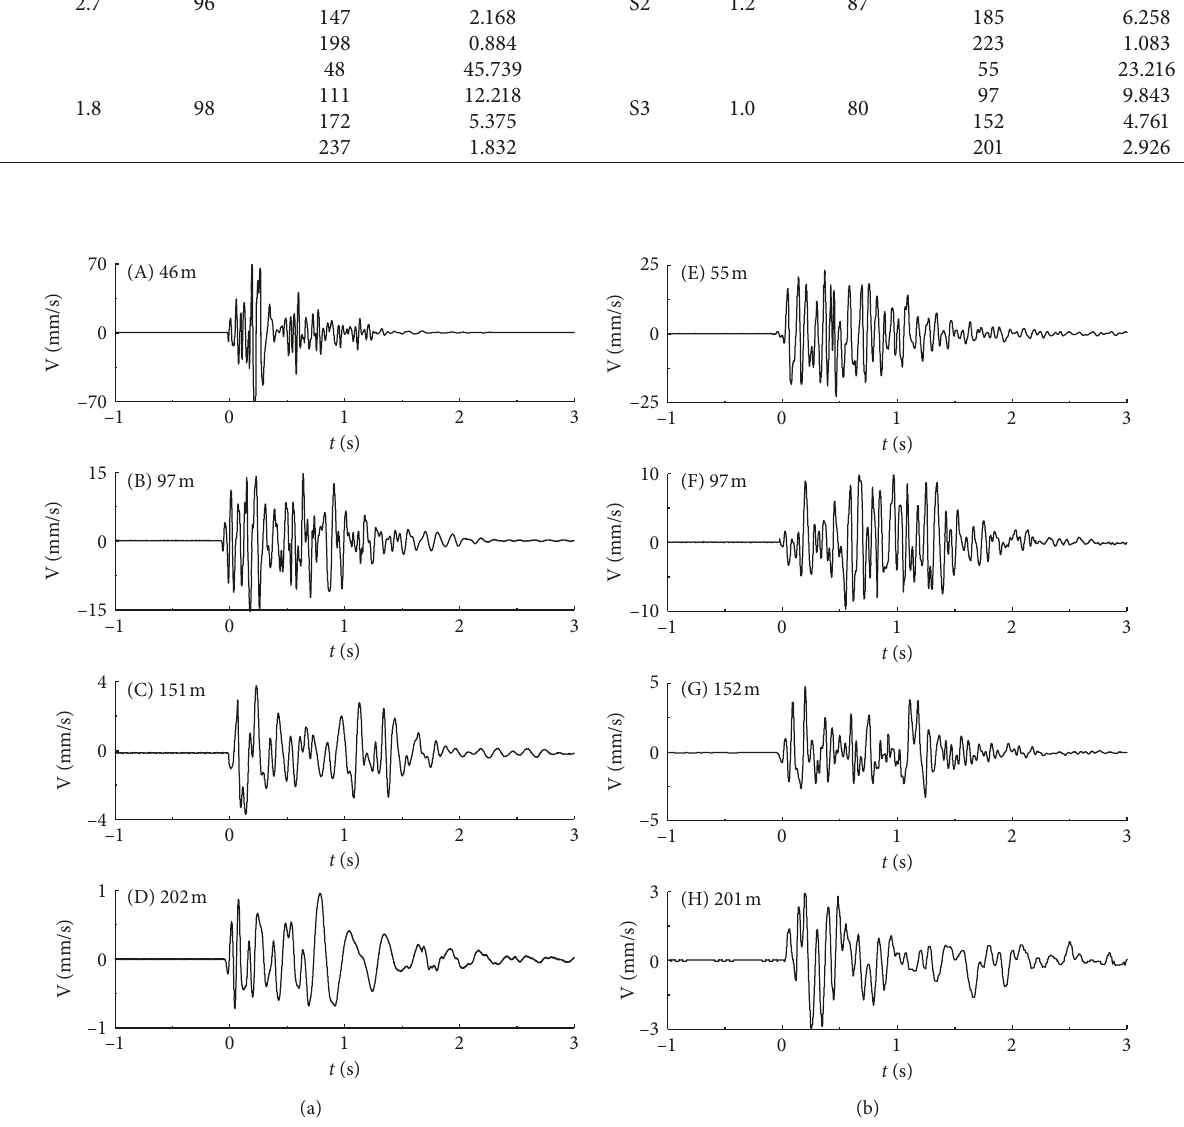
Figure 7: The velocity histories of blasting vibration monitoring. (a) D1. (b) S3.